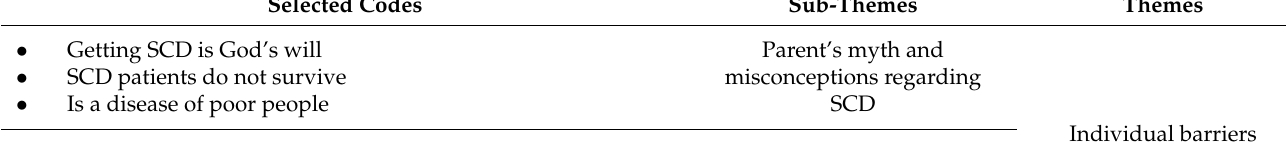
Table 2. Summary of